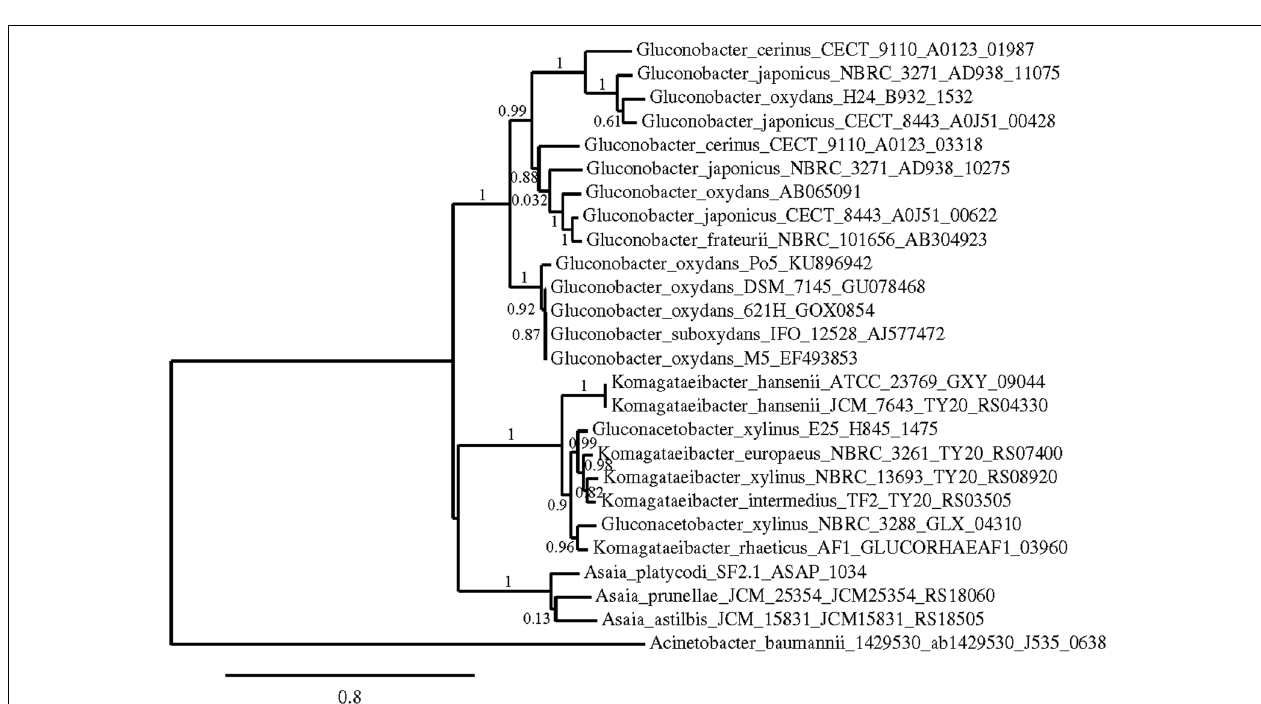
FIGURE 6 | Phylogenetic relationship of gnd L gene in different species of acetic acid bacteria. The entries of different genotypes include the accession numbers of the GeneBank database sequence. The sequence of one of the genes coding for GADH in Gluconobacter japonicus NBRC 3271 (AD938_03325) was used as outgroup. The numbers indicate the branch support values.